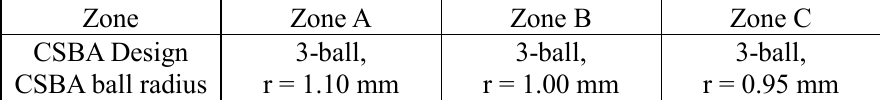
Figure 3: The CSBA Loading Scheme for the ATOM Core Table IV: CSBA Designs